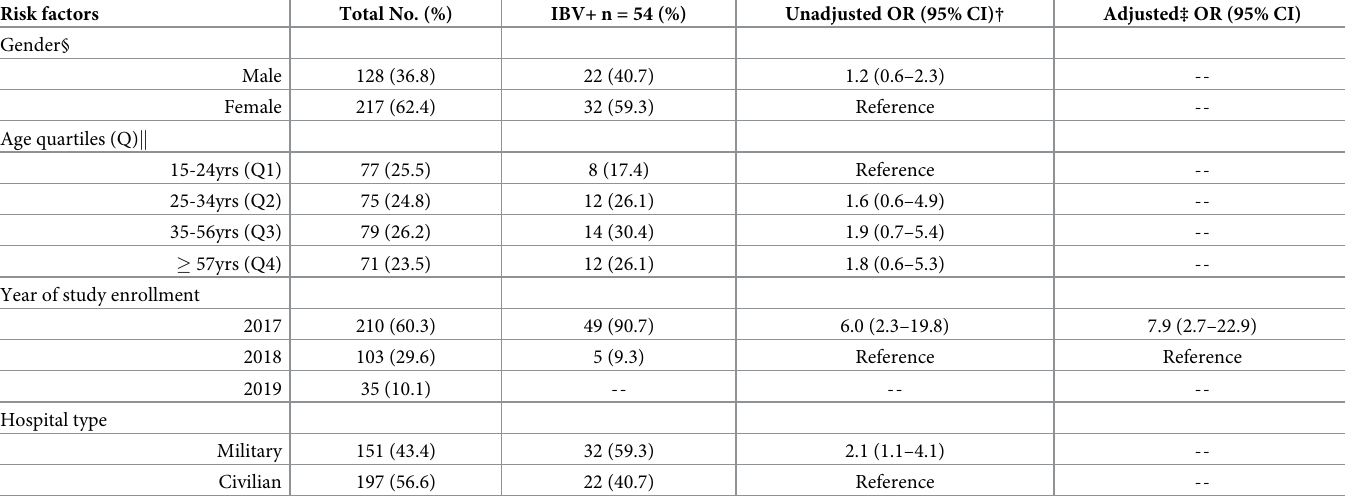
Table 4. Unadjusted and adjusted risk factor associations for Influenza B Virus (IBV) detection � among patients with severe acute respiratory illness in the Hanoi area,